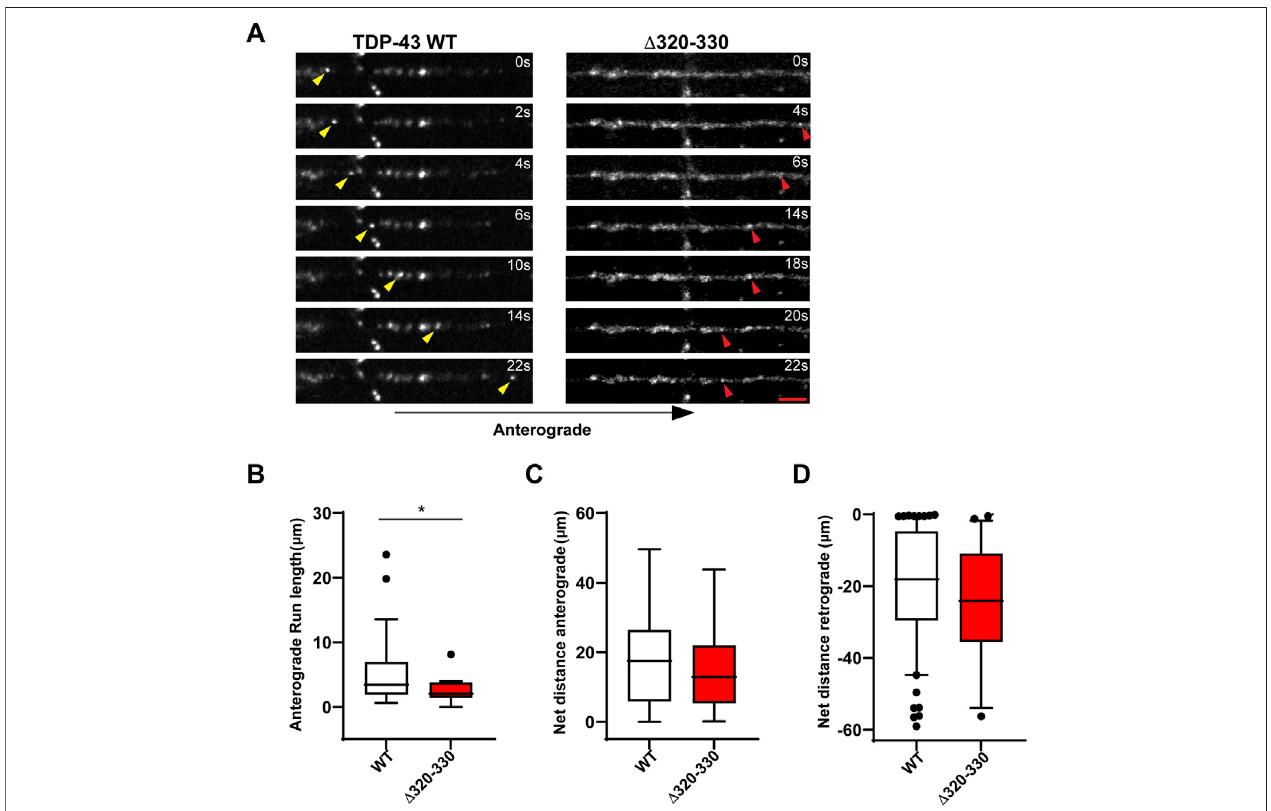
FIGURE 2 | Disrupting the α -helical domain impairs anterograde motility. (A) Time-lapse images of a representative motile TDP-43 WT RNP granule (left, yellow arrowhead) travelling in the anterograde direction and TDP-43 Δ 320-330 RNP granule moving retrograde (right, red arrowhead); scale bar: 3 μ m. (B) TDP-43 WT RNP granules exhibit signi fi cantly longer anterograde run lengths ( μ m) than RNP granules containing TDP-43 Δ 320-330. (C) The net distance ( μ m) anterograde or (D) retrograde travelled by motile WT and Δ 320-330 TDP-43 RNP granules. The values are from the 3 independent experiments (WT n = 134 and Δ 320-330 n = 36); plotted data represent mean ± SEM. Mann-Whitney test was used to determine statistical signi fi cance, * p < 0.05.